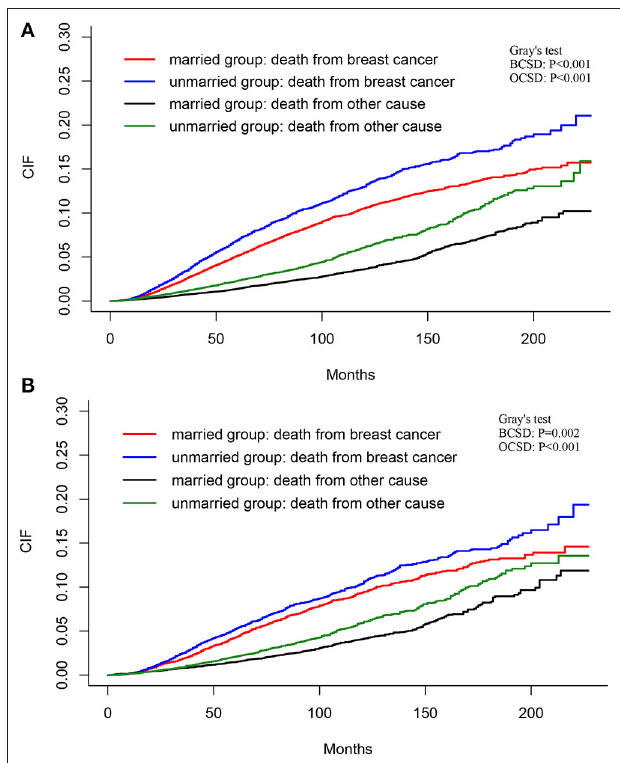
FIGURE 4 | Cumulative incidence estimates of BCSD and non-BCSD of patients before (A) and after (B) PSM. BCSD, breast cancer-specific death; PSM, propensity score